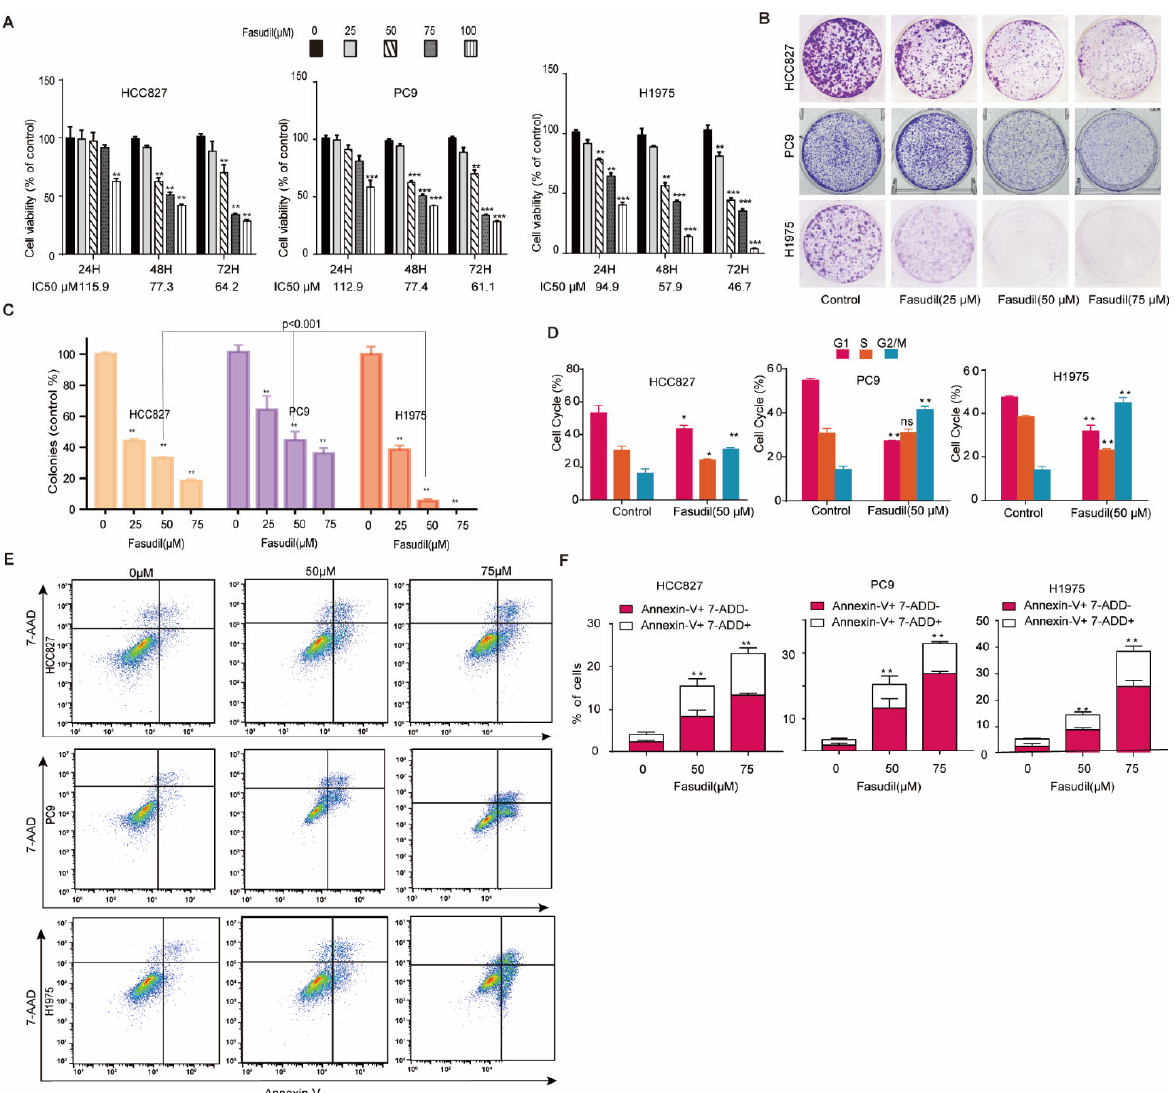
Figure 1. Inhibition of the growth of EGFR-mutation NSCLC cells in vitro by Fasudil. ( A ) Cell viability of EGFR-mutation NSCLC cells (HCC827, PC9, and H1975) treated with Fasudil at the indicated concentrations for 24, 48, and 72 h. The cell viability was analyzed via CCK-8 assay. All values are expressed as the mean ± SD ( n = 4). ( B ) Cell clone colonies formed by HCC827, PC9, and H1975cells treated with Fasudil (0, 25, 50, and 75 µ M). ( C ) Quantification of the colonies in each well. All values are expressed as the mean ± SD ( n = 3). ( D ) HCC827, PC9, and H1975 cells treated with 50 µ M Fasudil for 48 h, stained with PI, and analyzed via flow cytometry. Statistical graph showing the percentages of cells in the G0/G1, S, and G2/M phases in the cell cycle. All values are expressed as the mean ± SD ( n = 3). ( E ) HCC827, PC9, and H1975 cells treated with Fasudil for 48 h, double-stained with Annexin V-FITC/PI, and analyzed via flow cytometry. ( F ) Quantification of the apoptotic cells. All data are presented as mean ± SD based on triplicate measurements; * p < 0.05, ** p <0.01 and *** p < 0.001 were considered statistically significant. These observations indicated that Fasudil induced apoptosis in EGFR-mutation NSCLC cell lines in a dose-dependent manner, and 75 µ M Fasudil has a stronger apoptosis- promoting effect on gefitinib-resistant H1975 cells than gefitinib-sensitive cells (HCC827 and